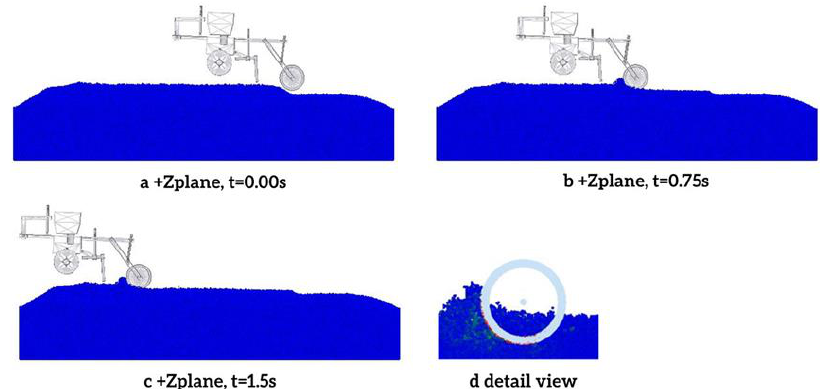
Figure 16. The screenshots of the soil-compacting simulation.